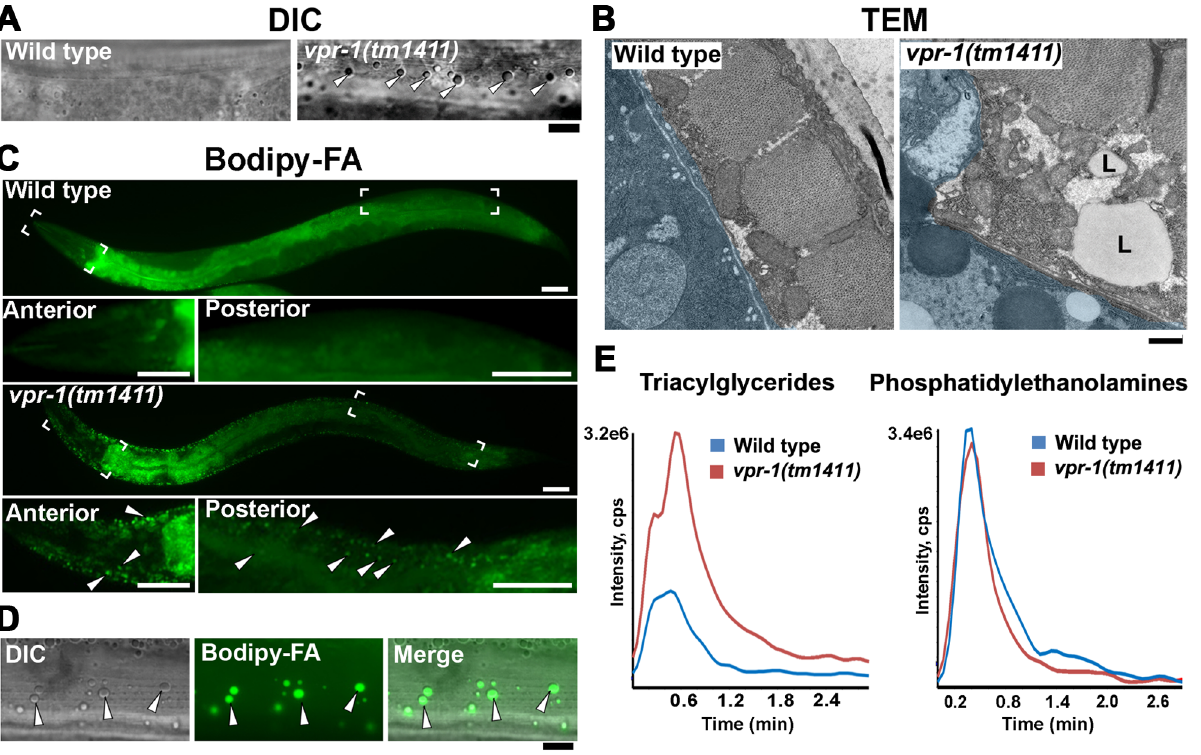
Figure 1. Fat levels in body wall muscle of wild-type and vpr-1 mutant worms. (A) DIC images of muscle in live adult hermaphrodites. Arrowheads indicate lipid-like droplets. Bar, 5 m m. (B) Transmission electron micrographs of body wall muscle cytoplasm in wild-type and vpr- 1(tm1411) mutant hermaphrodites. Light blue color demarcates muscle boundary. L, Lipid-like droplet. Bar, 0.5 m m. (C) Fluorescent images of muscle in live adult hermaphrodites fed Bodipy-FAs. Close-up images of boxed areas are shown below. Arrowheads indicate examples of Bodipy-FA-stained droplets. Anterior is to the left in all panels. Bars, 50 m m. (D) High magnification images of muscle showing Bodipy-FA-stained fluorescent droplets and droplets observed by DIC microscopy. Bar, 5 m m. (E) Comparison of total ion chromatograms of wild-type and vpr-1(tm1411) mutant adults extracts for 18:0 TAG (Neutral Loss 284) and phosphatidylethanolamine (Neutral Loss 141).